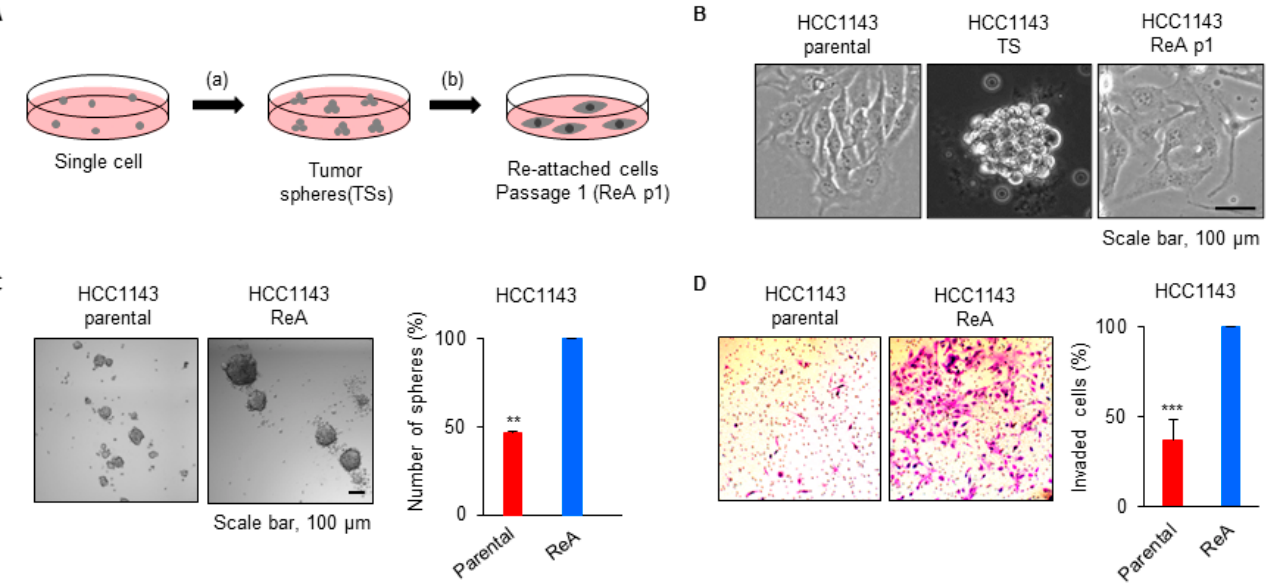
Figure 1. ReA cells after TS culture are more malignant than parental cells. ( A ) A scheme showing the culture methods for HCC1143 ReA cells. ( B ) Bright-field images of cells were taken with Axio Observer Z1 (Carl Zeiss, Jena, Germany). ( C ) Tumor sphere formation assay of parental and ReA cells. The proportion of tumor sphere cells was quantified as the mean ± standard of three independent experiments. Bright-field images of cells were taken with a cytation3 Cell Imaging Multi-Mode Reader. ** p < 0.01 relative to parental cells. ( D ) Boyden chamber invasion assay of parental and ReA cells. The proportion of invaded cells was quantified as the mean ± standard deviation of three independent experiments. *** p < 0.001 relative to parental cells.